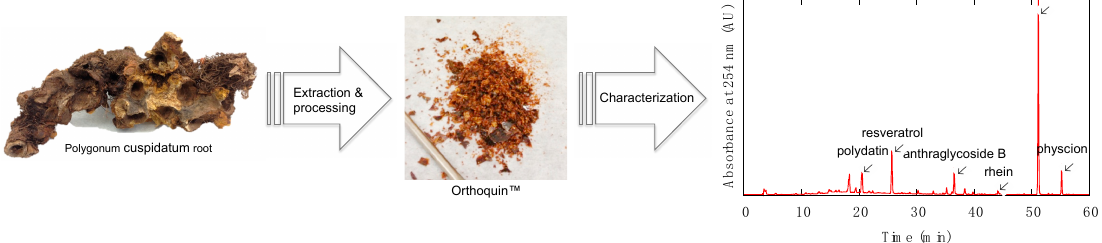
Figure 1. Overview of the preparation and characterization steps for producing Orthoquin TM .